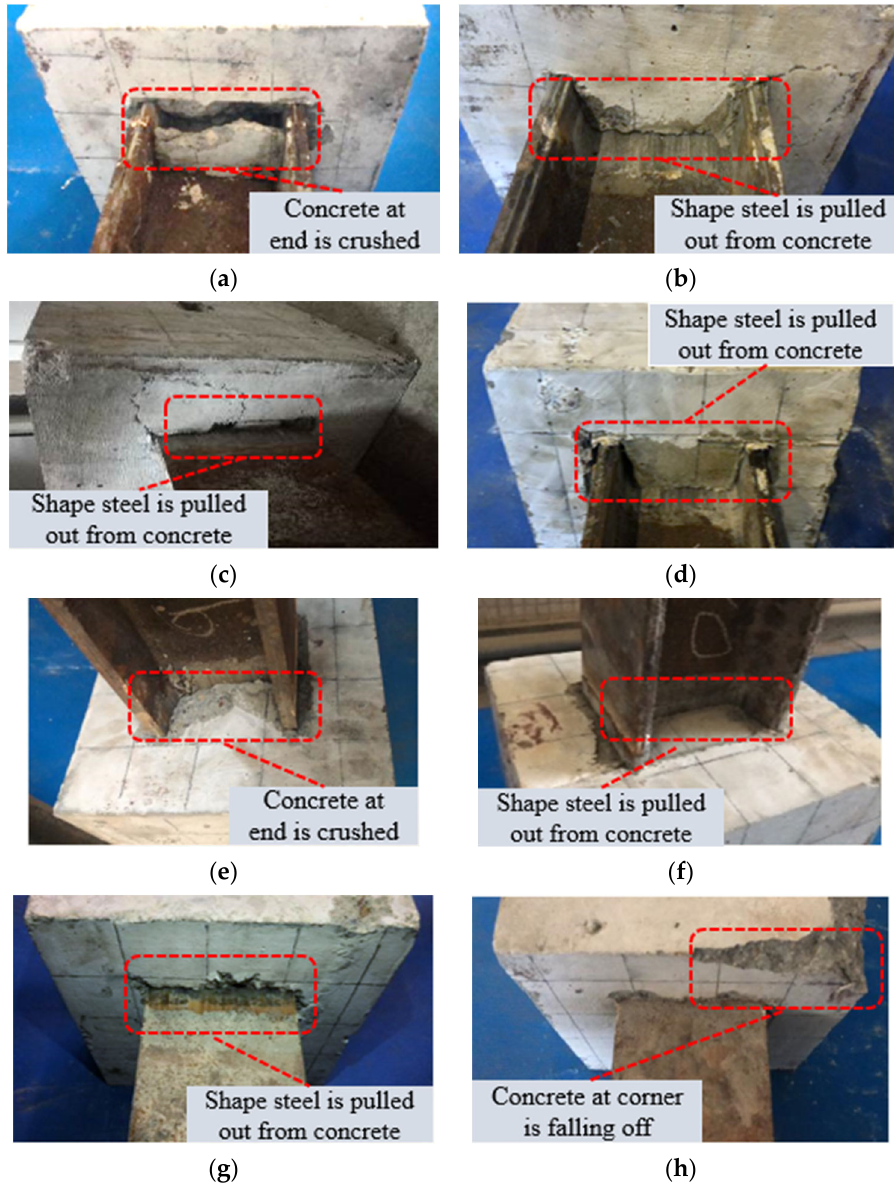
Figure 5. Typical failure modes of specimen, they should be listed as: ( a ) RCES-02; ( b ) RCES-03; ( c ) RCES-05; ( d ) RCES-08; ( e ) RCES-09; ( f ) RCES-10; ( g ) RCES-12; ( h )